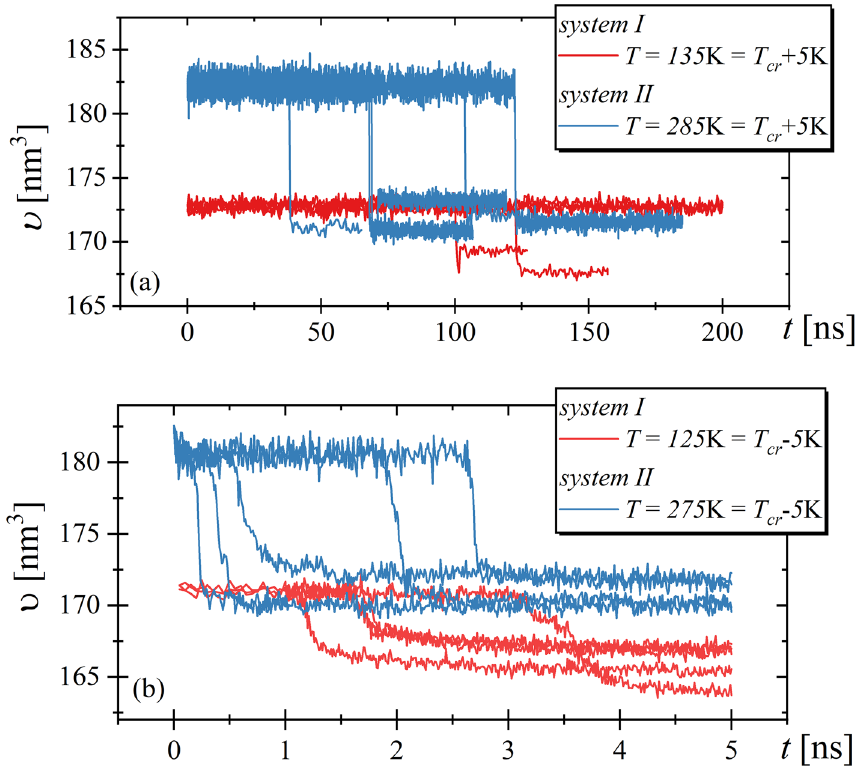
Figure 4. The time evolution of systems volumes at temperatures 5 K higher (top) and lower (bottom) than the temperature at which RMs systems crystallized during